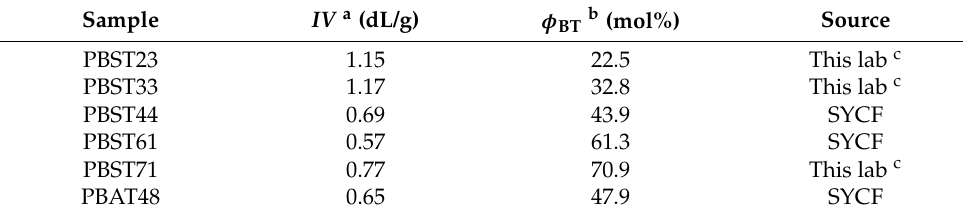
Table 2. Intrinsic viscosity ( IV ) and copolymer composition ( φ BT ) of the copolyesters.